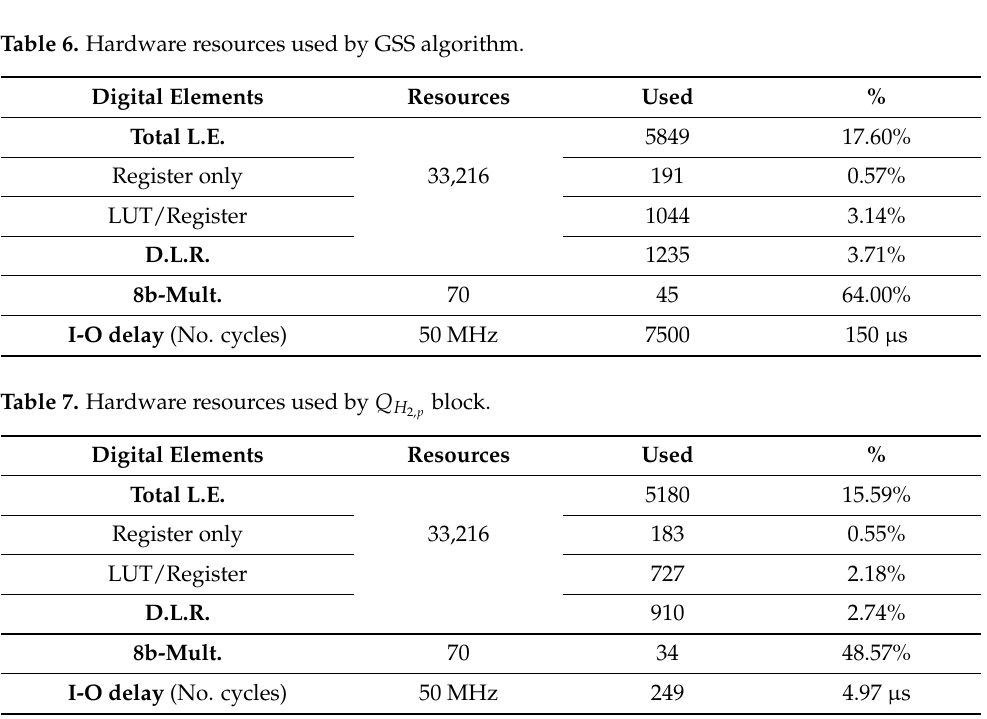
Table 6. Hardware resources used by GSS algorithm.